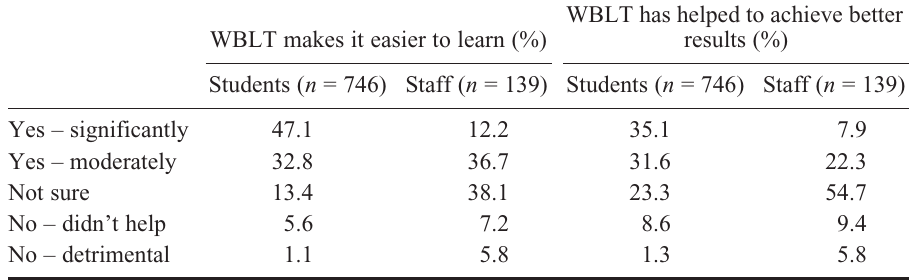
Table 1. Comparison of student and staff perceptions of the effectiveness of